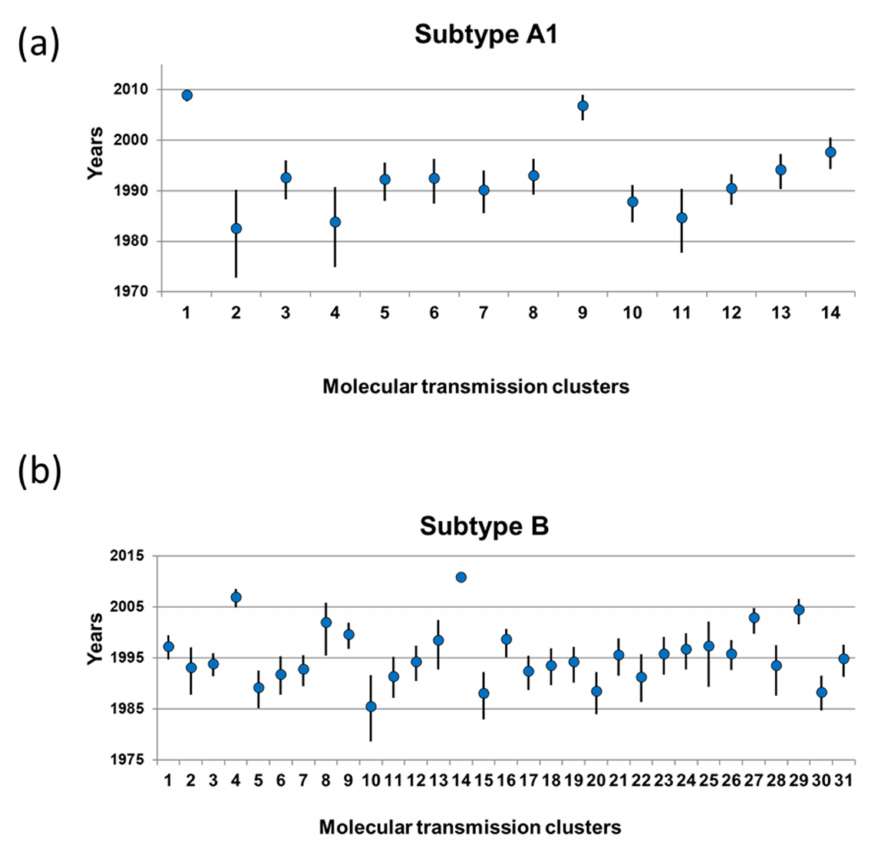
Figure 2. ( a ) Molecular clock calculations of the time of the most recent common ancestor (tMRCA) for the 14 HIV-1 subtype A1 molecular transmission clusters (median, 95% HPD interval). ( b ) Molecular clock calculations of the tMRCA for the 31 HIV-1 subtype B molecular transmission clusters (median, 95% HPD interval). Dots indicate the median estimations and horizontal lines the 95% HPD intervals. Table 2. Time of the most recent common ancestor (tMRCA) in years of subtype A1 and B molecular transmission